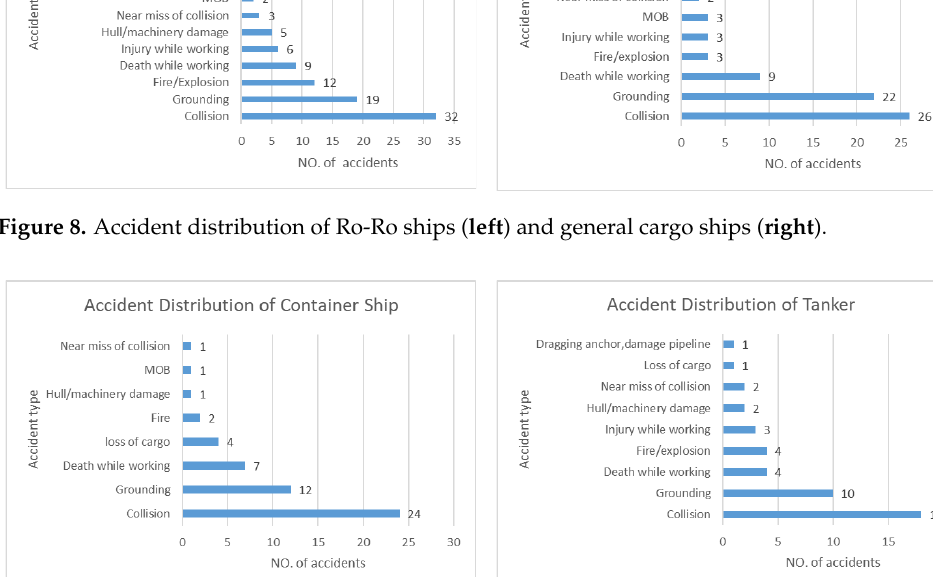
Figure 8. Accident distribution of Ro-Ro ships ( left ) and general cargo ships ( right ). Figure 9. Accident distribution of container ships ( left ) and tankers ( right ).